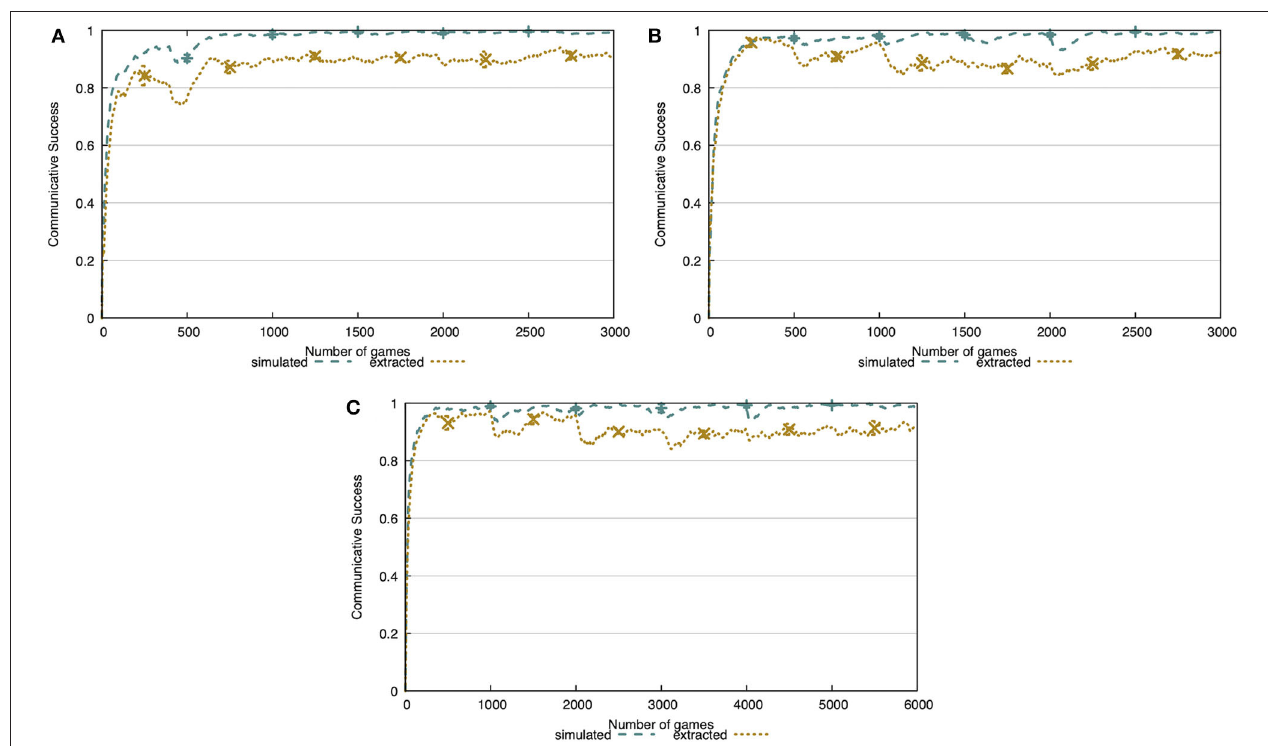
FIGURE 10 | Communicative success in the incremental learning experiment. A new split is introduced every 100 interactions (A) , 500 interactions (B) , or 1,000 interactions (C) . The learning mechanism is completely open-ended, allowing the agent to adapt to a changing environment without any issues. Note that the x-axes vary to best show the changes in communicative